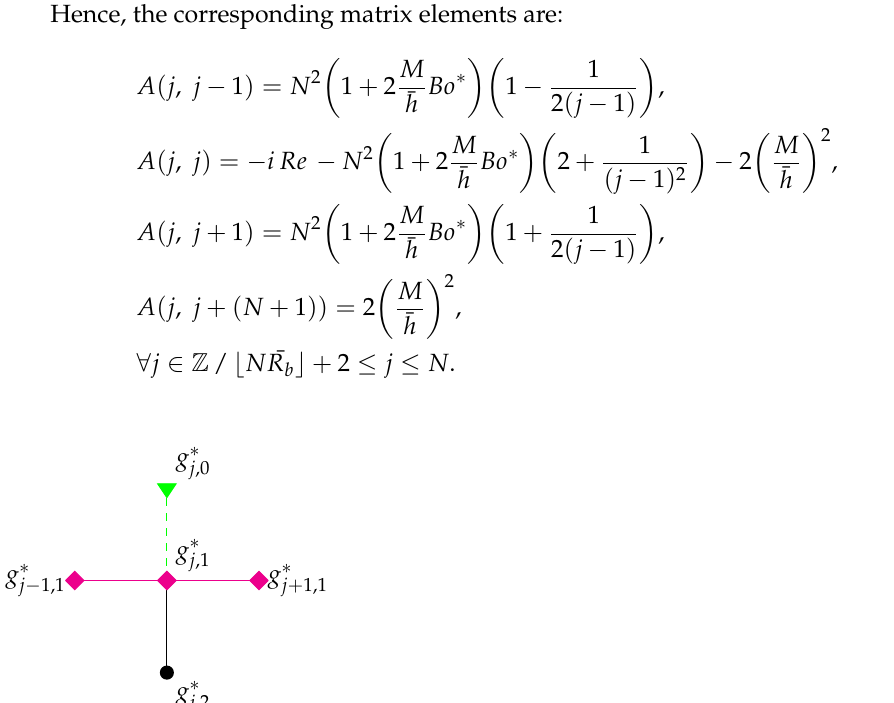
Figure 2. Four node scheme at the interface. Black dot: node inside the fluid subphase. Magenta diamonds: nodes at the interface. Green down triangle: phantom node above the